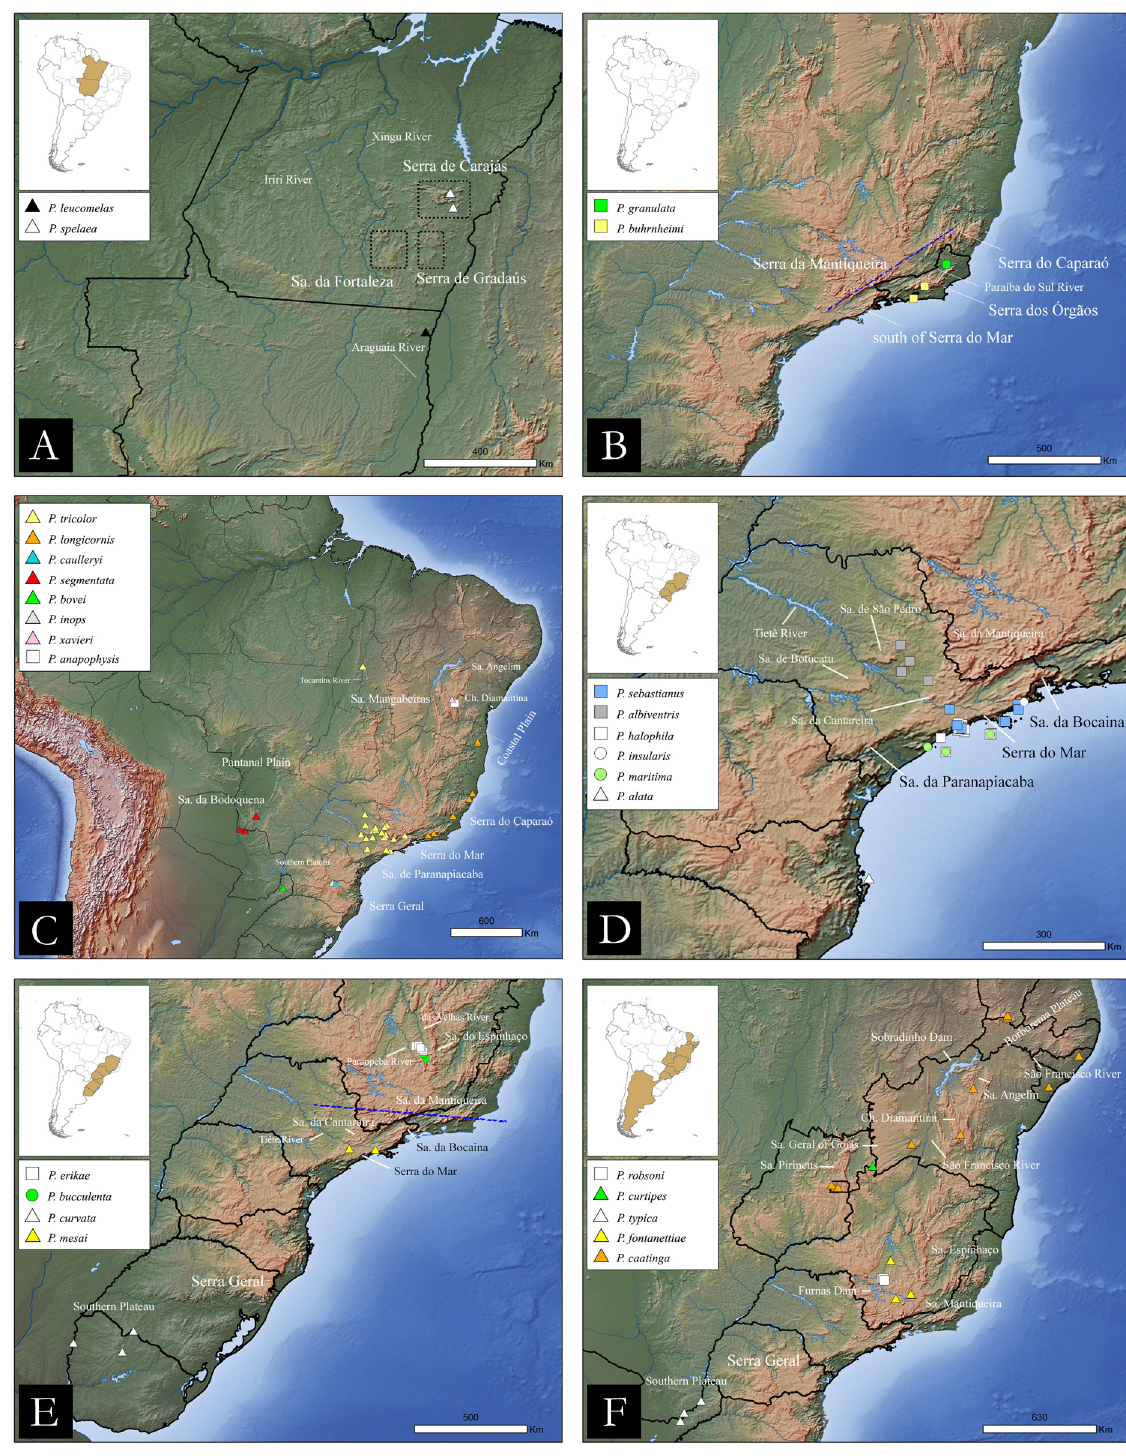
Fig. 16. Biogeographic history of the clades recovered in the analysis. A . Clade 15 (the stippled rectangles refer to the delimitation of the mountain ranges Fortaleza, Gradaús, and Carajás). B . Clade 38. C . Clade 39. D . Clade 29 (record of Pseudonannolene patagonica Brölemann, 1902 in Argentina is omitted). E . Clade 25. F . Clade